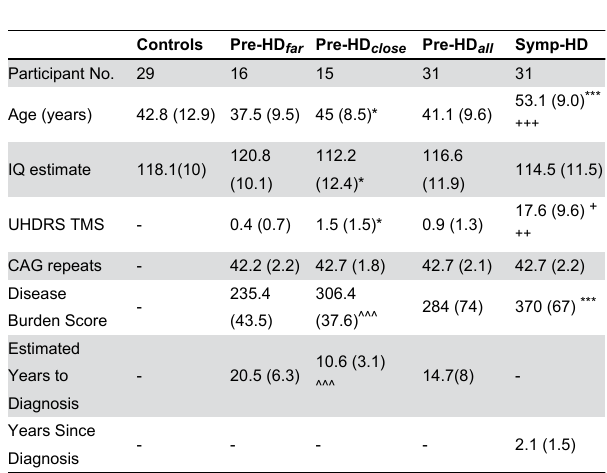
Table 1. Demographic and clinical baseline data across